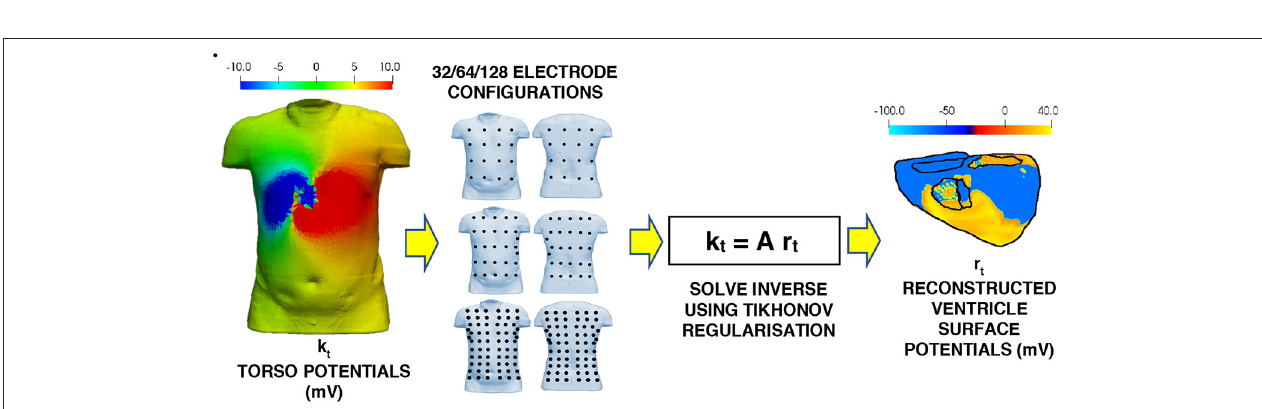
FIGURE 2 | Workflow for the inverse problem. Multi-lead ECG’s using the various electrode configurations to the torso potential results from the forward problem. The BSP for the torso is then interpolated from the multi-lead ECG’s. This interpolated BSP is then used as the torso potentials in the inverse solution to produce the epicardial potentials on the